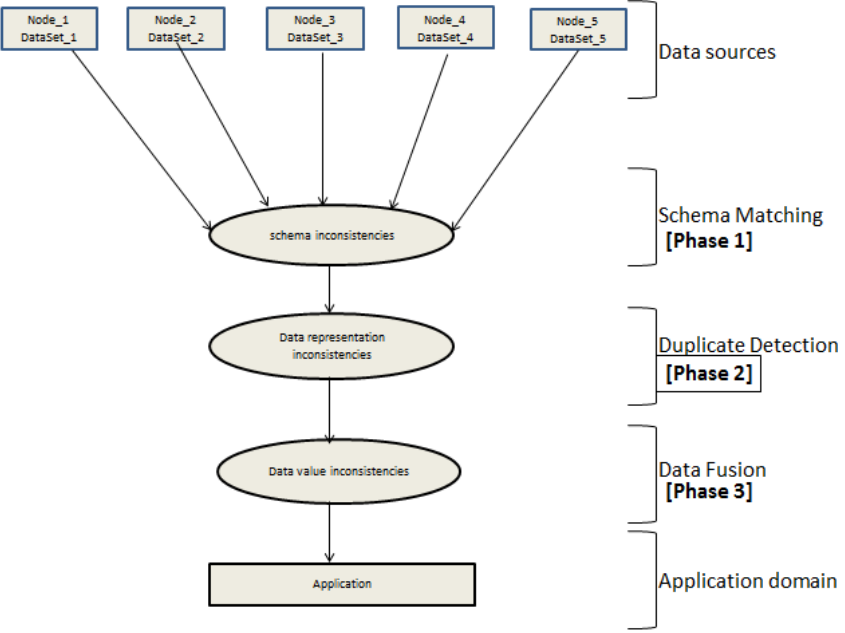
Figure 3. Architecture of datasets fusion and inconsistency